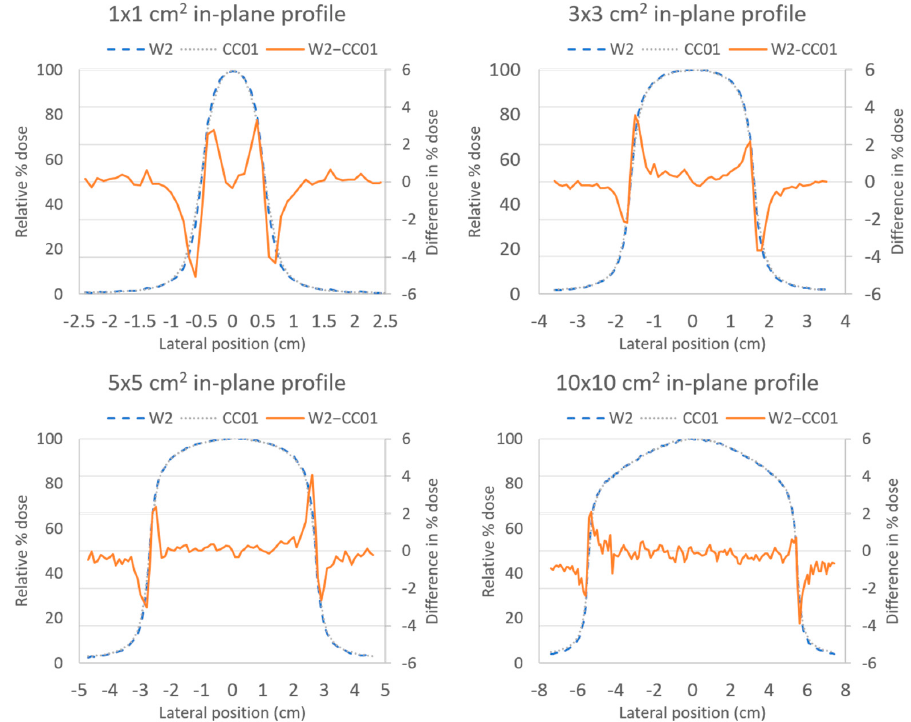
Figure 3. In-plane profiles measured with the Exradin W2 scintillator (blue) and the CC01 ion chamber (gray) using a 10 MV FFF beam at 100 cm source-to-surface distance for various field sizes. The difference between the two measurements (W2–CC01, orange) was less than 5% at all points and less than 1% at depths outside of the penumbra region.